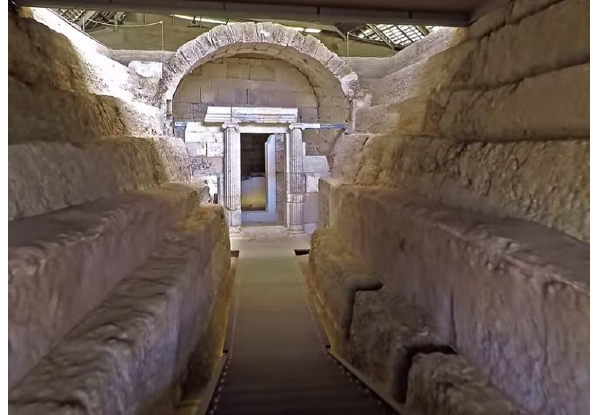
Figure 2: The Macedonian tomb of Macridy Bey